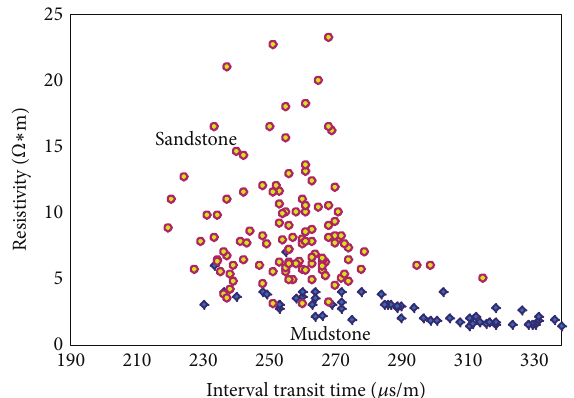
Figure 8: The relationship between interval transit times and resistivity.